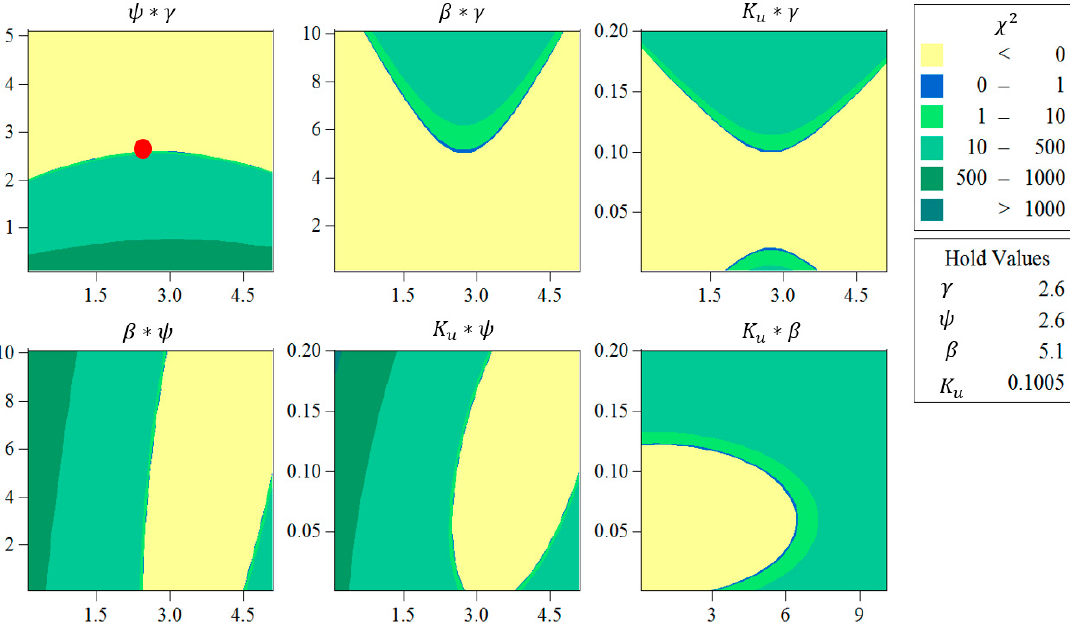
Figure 7. Contour plots representing the distribution of χ (cid:2870) as a function of the pitting parameters ( γ , ψ , β , and K (cid:2931)